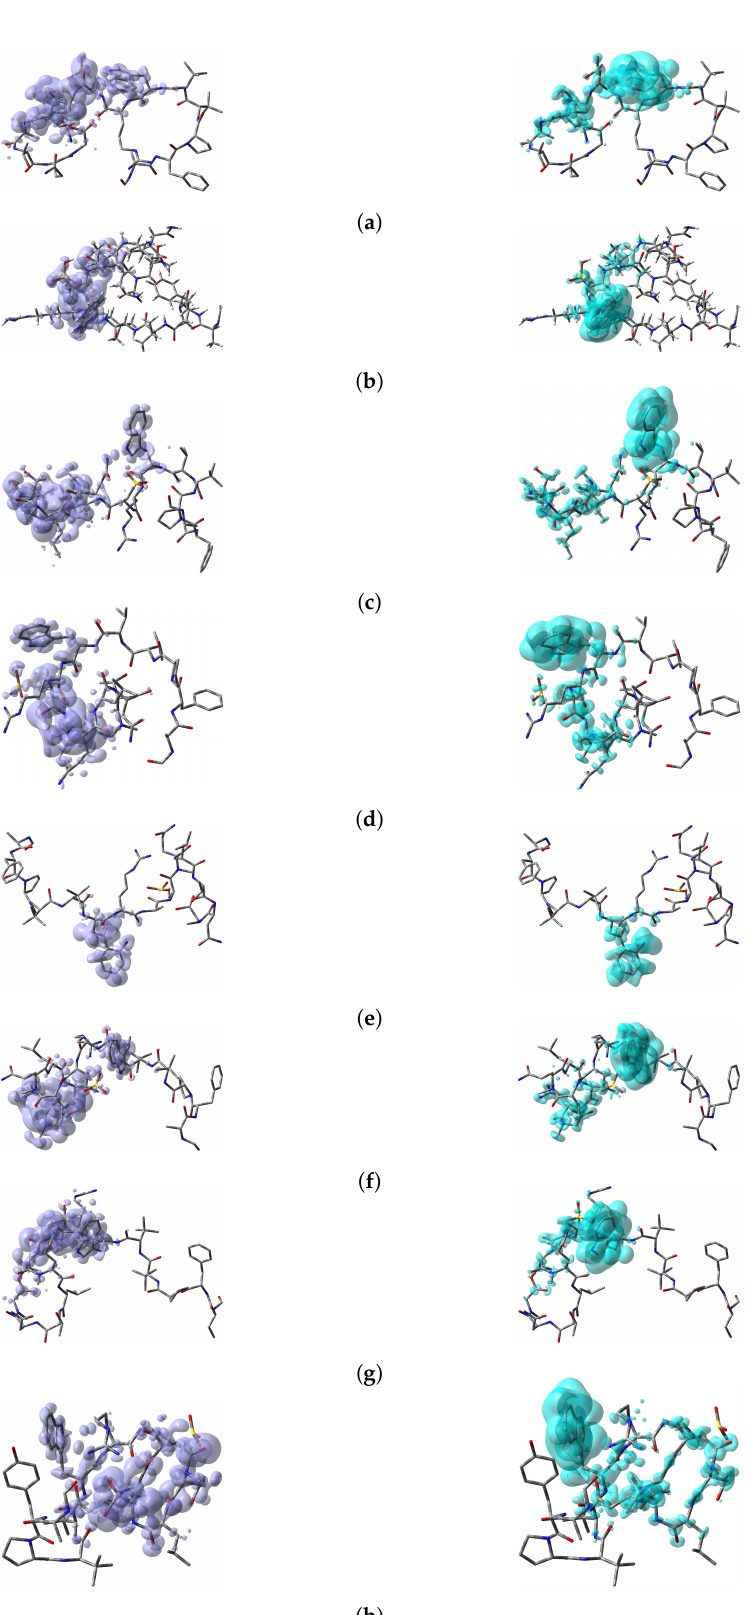
Figure 5. Graphical representation of the Dual Descriptor DD of the ( a ) Discodermin A, ( b ) Discodermin B, ( c ) Discodermin C, ( d ) Discodermin D, ( e ) Discodermin E, ( f ) Discodermin F, ( g ) Discodermin G and ( h ) Discodermin H molecules. Left: DD > 0, Right: DD <